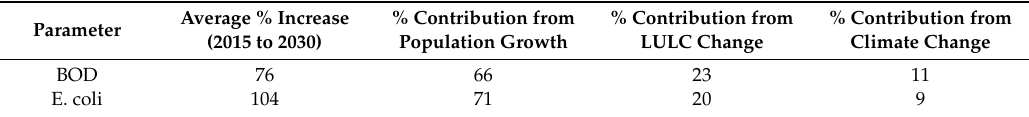
Table 2. Summary for order of contribution of di ff erent drivers on water quality deterioration in Santa Rosa sub-watershed.